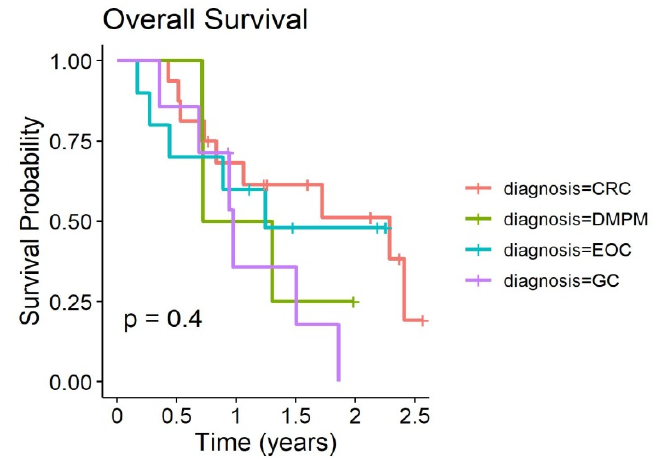
Figure 4. Overall Survival of 20 patients with PC stratified by pathologies treated with at least two PIPAC procedures.